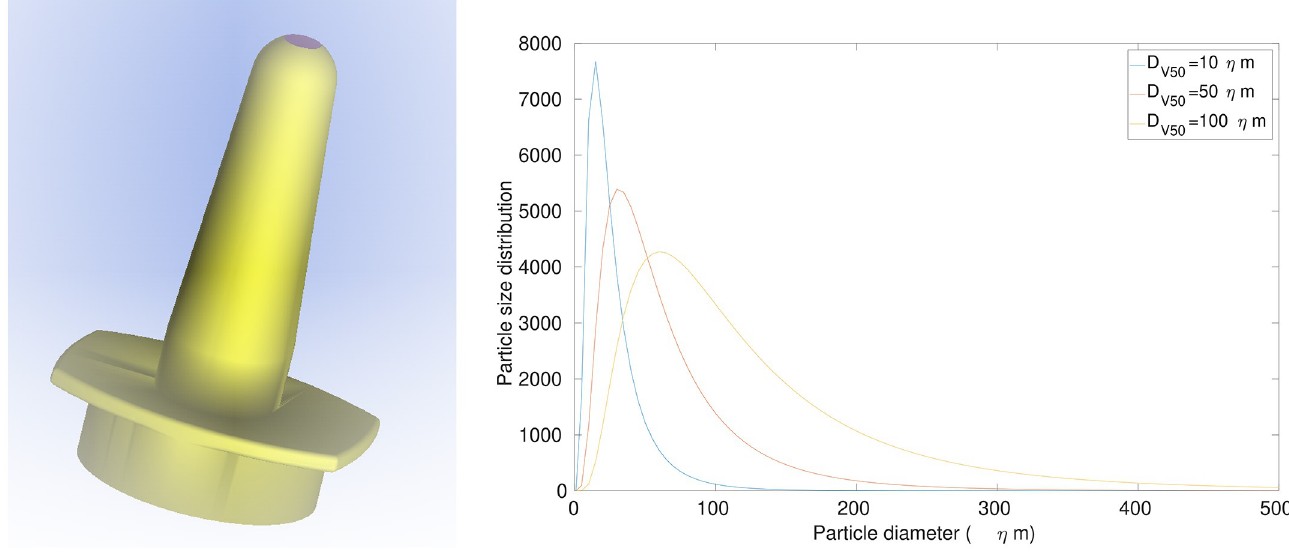
Fig 4. Log-normal distribution function showing the profiles for medians of DV 50 = 10, 50, 100.